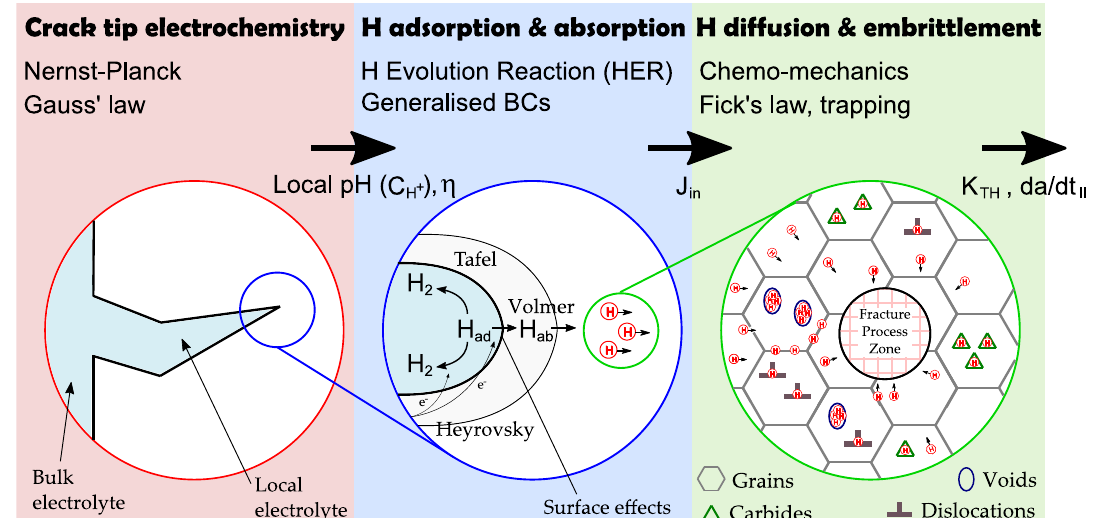
Figure 2. Stages involved in the hydrogen uptake and embrittlement processes: (1) electrochemistry (red), (2) electrochemistry-diffusion interface (blue), and (3) diffusion and trapping